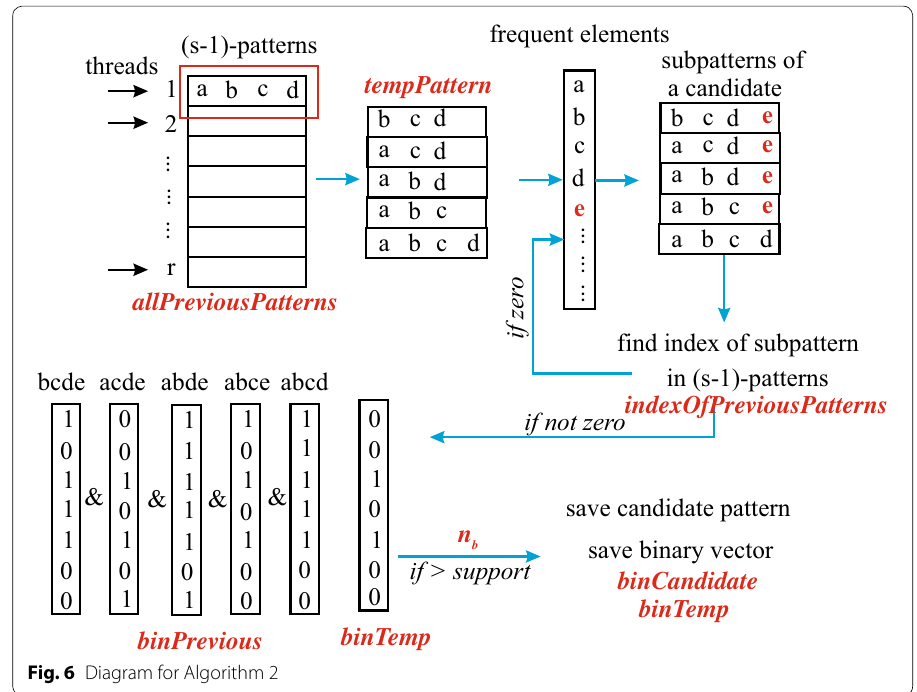
Fig. 6 Diagram for Algorithm